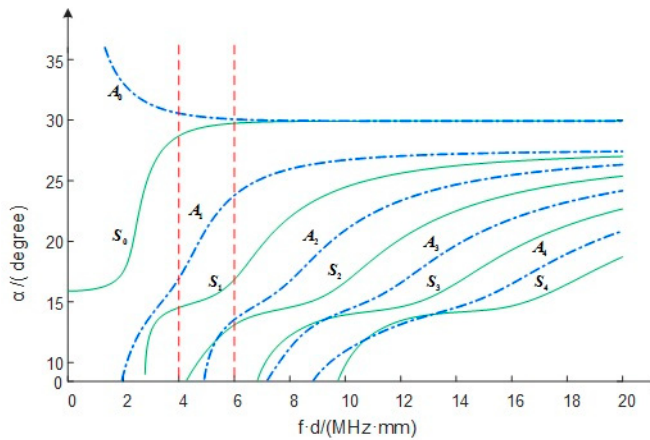
Figure 4. Relationship between the incident angle and frequency-times-thickness in steel (the P-wave velocity in water was 1480 m / s).